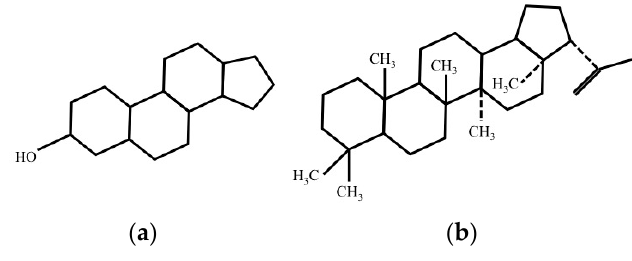
Figure 4. Structure of: ( a ) Sterols; and ( b ) Hopanoids.